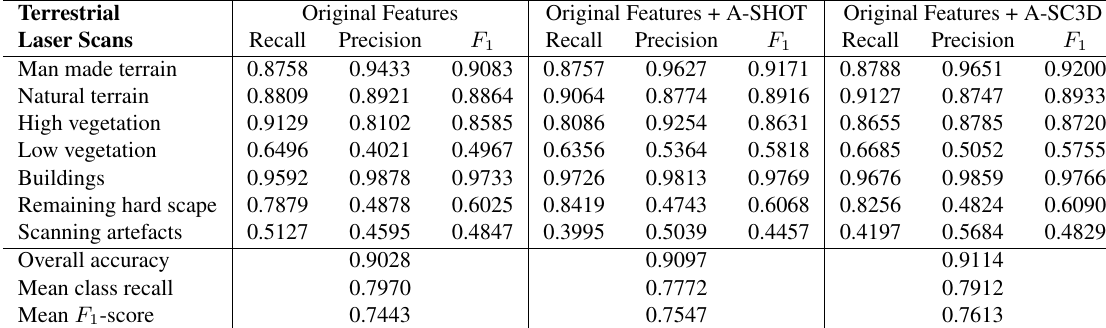
Table 4. Quantitative results for terrestrial laser scans.